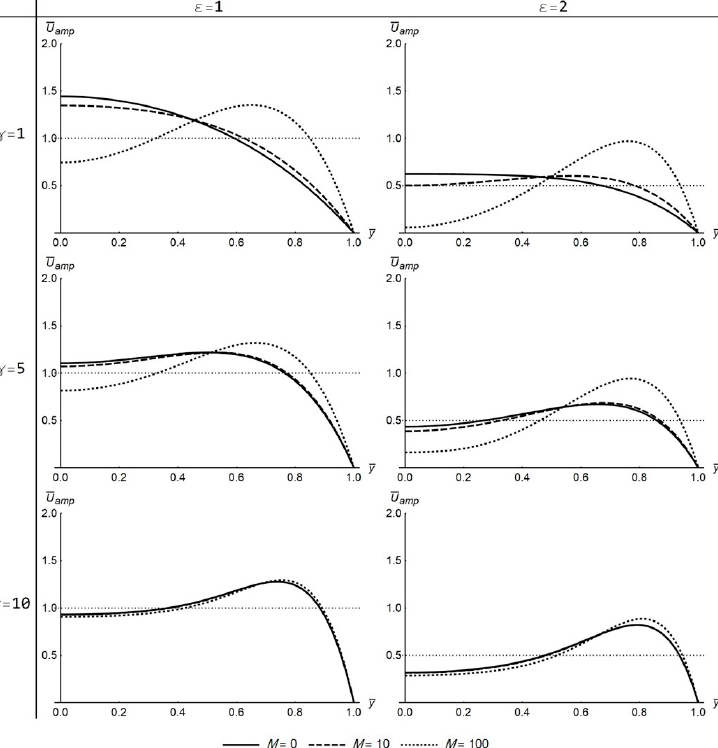
Figure 10. The profiles of U amp under the effect of ε , γ , and M parameters (parallel case). Figure 10. The profiles of 𝑈(cid:4636) (cid:3028)(cid:3040)(cid:3043) under the effect of 𝜀 , 𝛾,𝑎𝑛𝑑 𝑀 parameters (parallel case). Figure 10. The profiles of 𝑈(cid:4636) (cid:3028)(cid:3040)(cid:3043) under the effect of 𝜀 , 𝛾,𝑎𝑛𝑑 𝑀 parameters (parallel case).